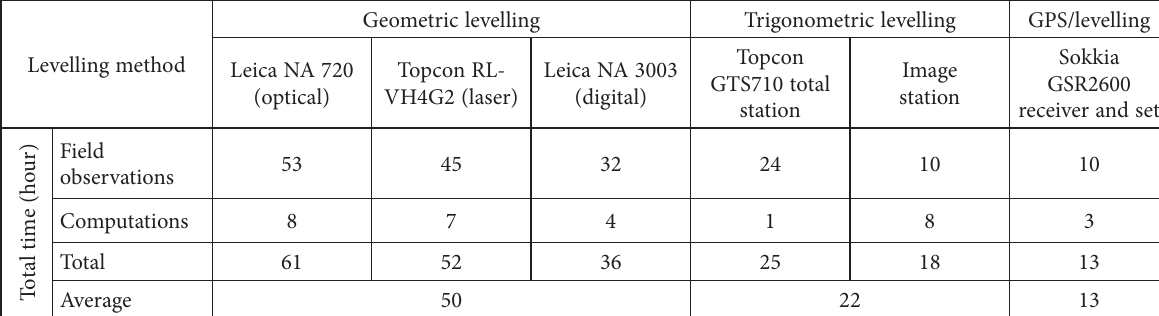
Table 7. Time comparison between the different levelling methods